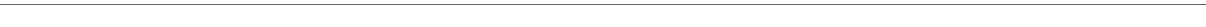
FigUre 6 | mTOR complex 2 transcriptionally regulates signature programming of follicular helper CD4 + T (T FH ) cells. (a) Gene-set-enrichment analysis of gene signatures that were upregulated (top) or downregulated (bottom) in T FH cells relative to their expression in non-T FH cells, T FH cells were sorted from Rictor − / − and WT mice at day 8 after infection with lymphocytic choriomeningitis virus (GEO accession codes GSE21379 and GSE21381). (B) Heat-map representation of the expression of the top 71 genes selected from (a) . Red, high gene expression; green, low gene expression. (c) RT-quantitative polymerase chain reaction of selected 12 genes from the microarray data (see Table S3 in Supplementary Material) normalized to the expression level in WT T FH cells ( n = 3 samples per group). ns, not significant, * p < 0.05, ** p < 0.01, *** p < 0.001, **** p < 0.0001 [unpaired two-tailed t -test (c) ]. Data are from one experiment with two biological replicates pooled from six Rictor − / − mice and four WT mice per group (a,B) or are representative of two independent experiments (c) . Error bars are SEM (c)